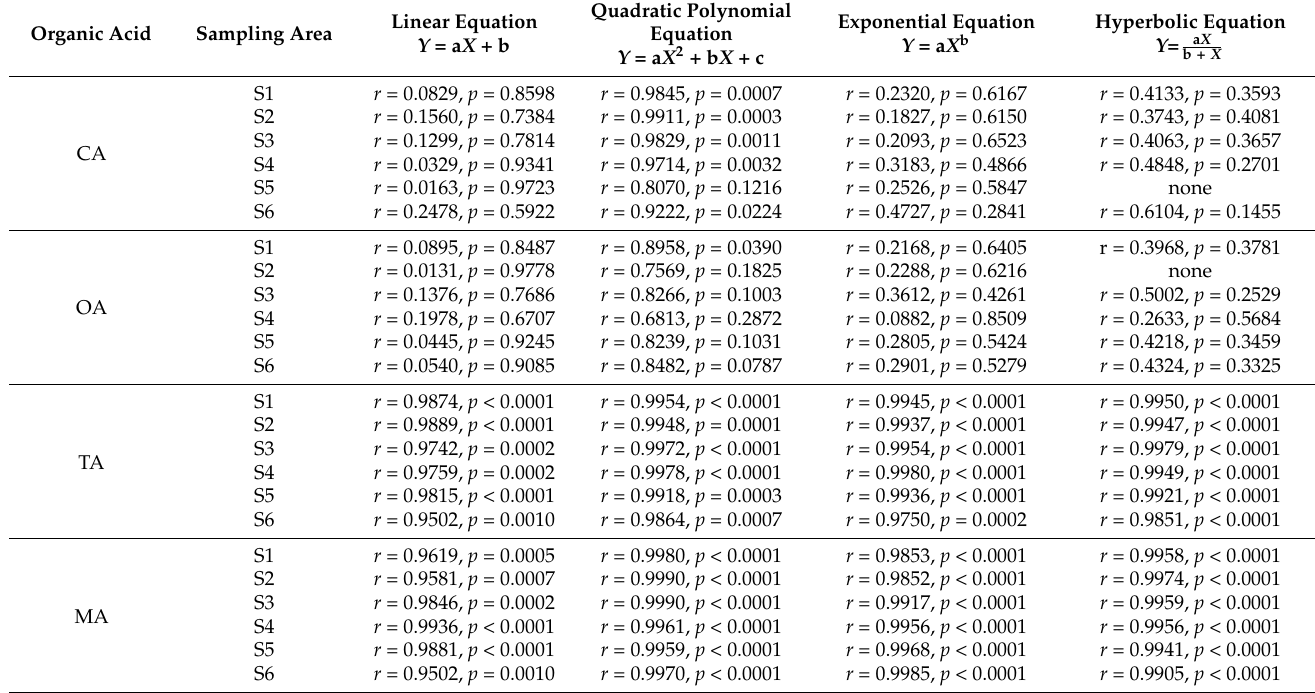
Table 3. The different fitting equations simulating the P extraction rates of the four organic acids.